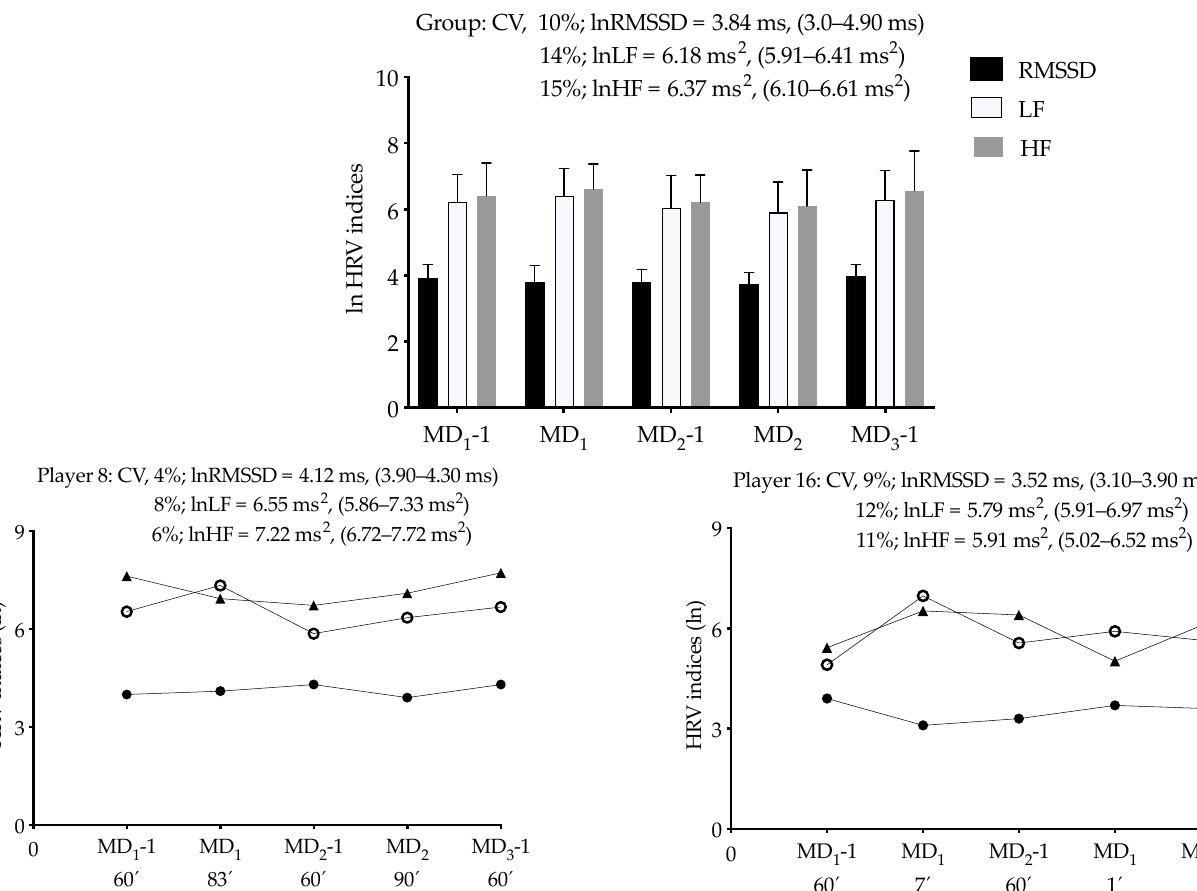
Figure 3. Analytical graph of the group (mean and 95% confidence interval) and individual cardiac parasympathetic activity (measured as natural logarithm of the root mean square of successive R-R intervals (lnRMSSD), natural logarithm of low frequency (lnLF), and as natural logarithm of high frequency (lnHF)) values of two players for each day of the tournament. Averages, maximum and minimum values are also presented. Abbreviations: MD, Match-day; CV, coefficient of variation.